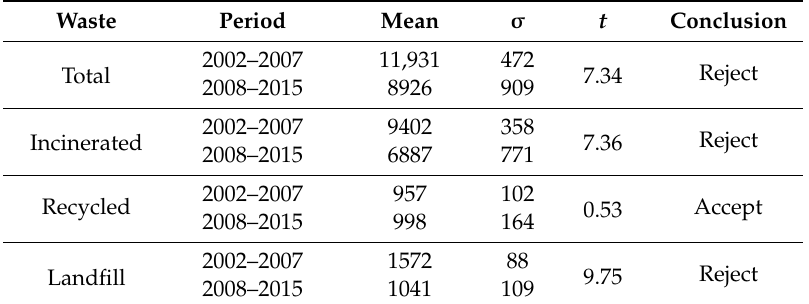
Table 4. Two sampled t -test results for quantities of waste 2002–2007 compared to 2008–2015. Waste Period